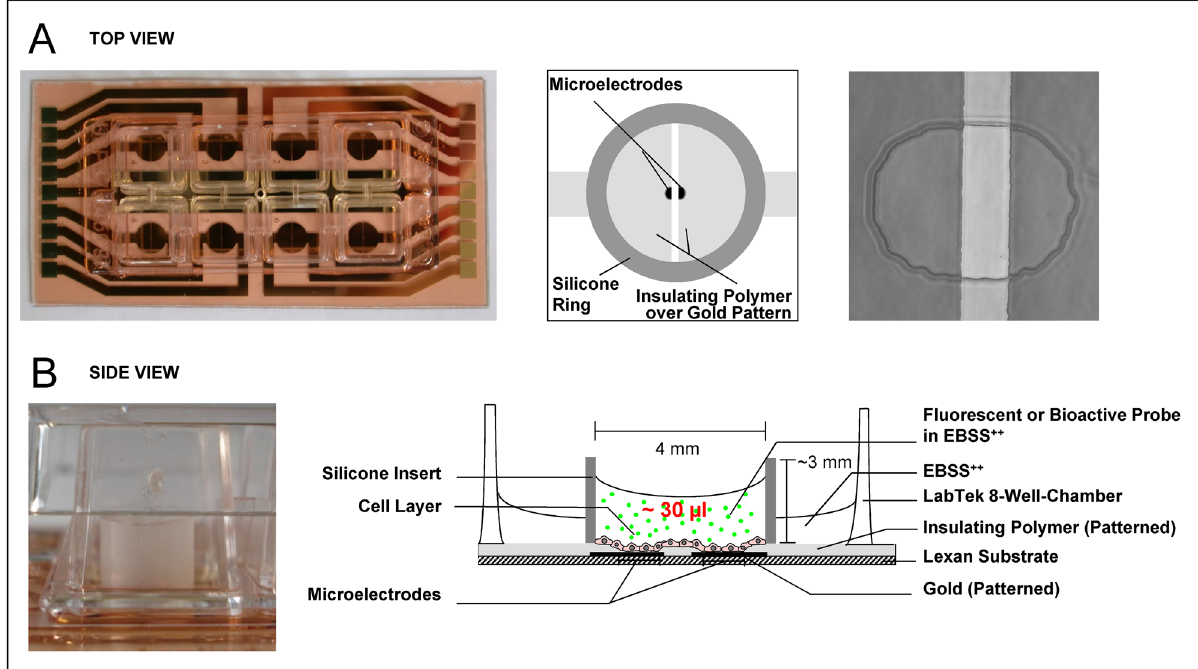
Figure 1. Experimental setup for combined in situ electroporation (ISE) and impedance-based cell monitoring (ECIS) in small sample volumes. ( A ) Top view. ( B ) Side view. ( A ) Top view of an 8-well electrode array (left), a schematic top view into one well of the electrode array after modification with an inserted silicone ring (middle) and a phase contrast micrograph of the two semi-circular, cell-free electrodes defined by openings in an overlaying passivation layer (right). ( B ) Side view of one well of an electrode array modified with a silicone chamber (left) and schematic side view into one well (right). Note that dimensions are not to scale. Details are given in the main